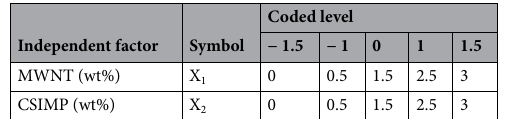
Table 1. Real and coded levels of variables.